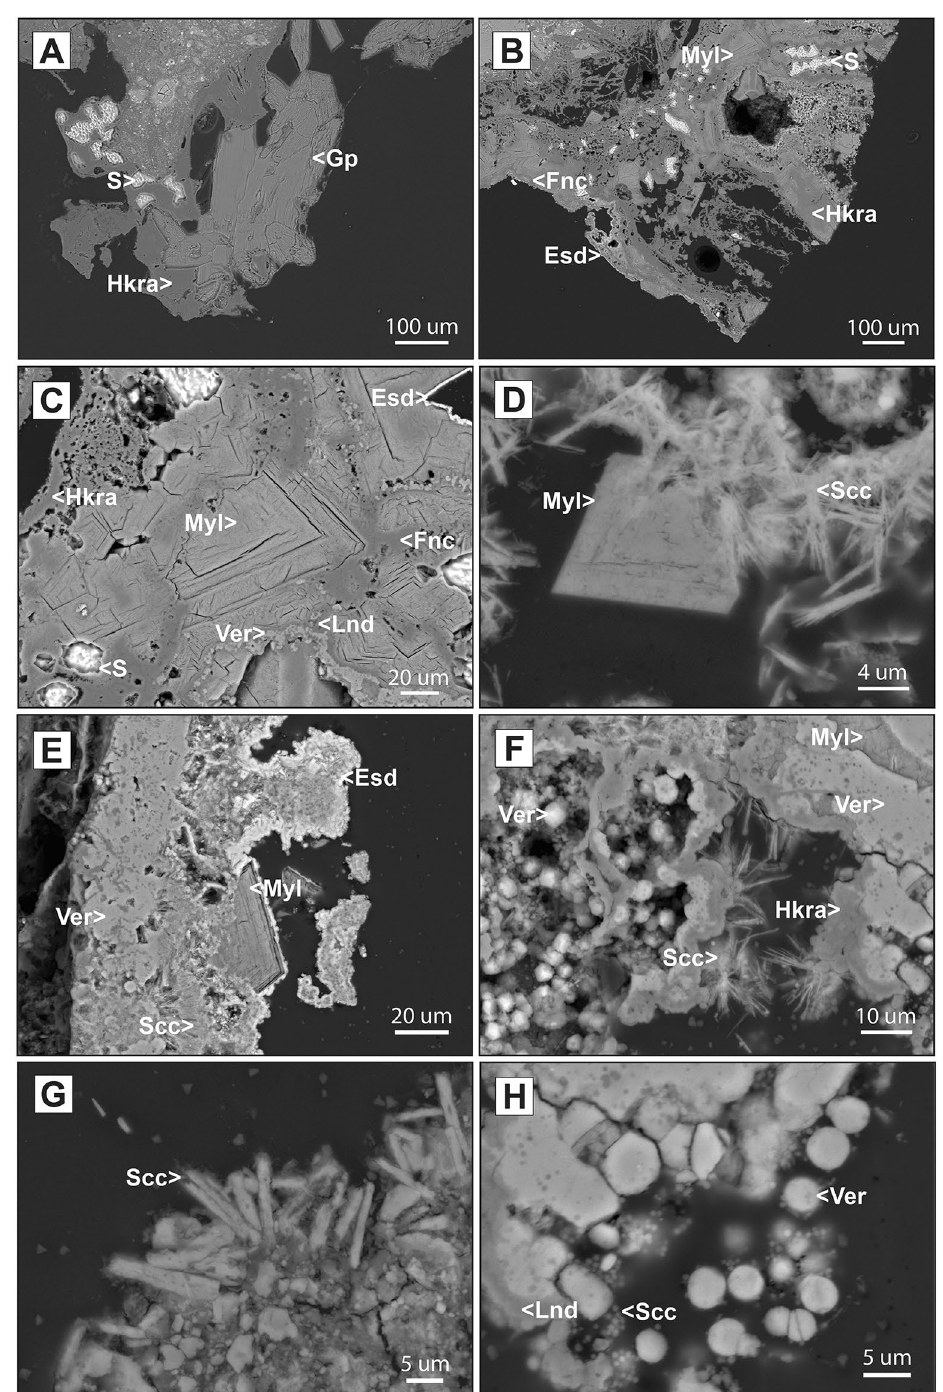
Figure 6. SEM (backscattered electron, BSE) images of the Tajogaite fumarolic mineralization. ( A ) Euhedral crystals of gypsum (Gp) associated with hydrokenoralstonite (Hkra) and skeletal crystals of native sulphur (S). ( B ) Skeletal crystals of native sulphur (S) typically associated with Al–Mg–Ca–Na fluorides: hydrokenoralstonite (Hkra), fluornatrocoulsellite (Fnc) and meniaylovite (Myl) covered by a later patina of erytrosiderite (Esd). ( C ) Complete Al–Mg–Ca–Na fluoride assemblage of the Tajogaite area: hydrokenoralstonite (Hkra), leonardsenite (Lnd), verneite (Ver) and fluornatrocoulsellite (Fnc) with the typical later patina of erytrosiderite (Esd). ( D ) Euhedral crystal of meniaylovite (Myl) associated with acicular aggregates of sbacchiite (Scc). ( E ) Erytrosiderite (Esd) covering and euhedral crystal of meniaylovite (Myl) associated with verneite (Ver) and acicular crystals of sbacchiite (Scc). ( F ) Globular aggregates of verneite (Ver) associated with leonardsenite (Lnd) and later sbacchiite (Scc). ( G ) Detailed view of acicular aggregates of sbacchiite (Scc). ( H ) Typical fluorides assemblage composed of hydrokenoralstonite (Hkra), botryoidal verneite (Ver), meniaylovite (Myl) and later acicular crystals of sbacchiite